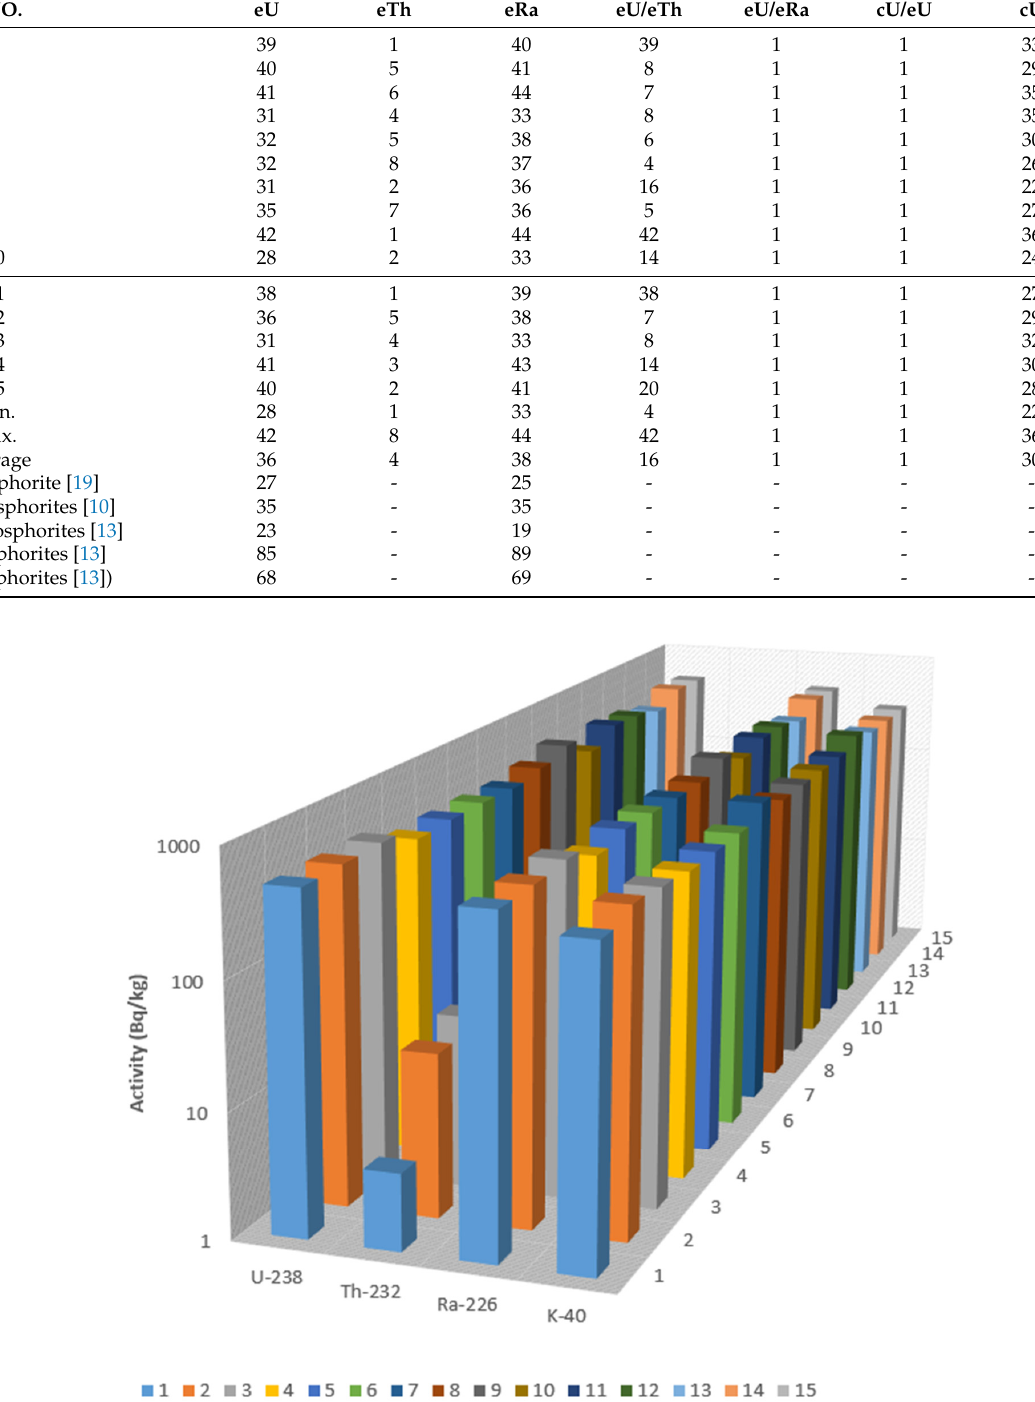
Figure 6. The samples represent the radiometric measurements of 238 U, 226 Ra, 232 Th, and 40 K